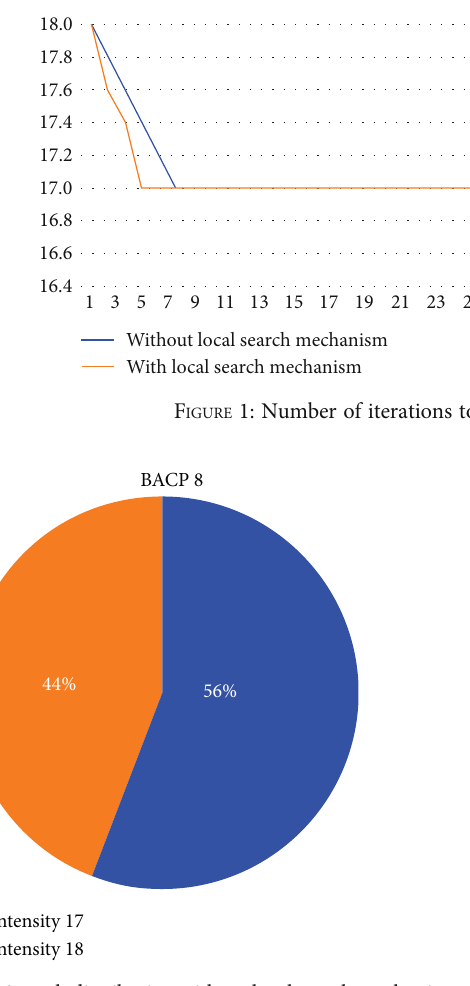
F IGURE 3: BACP 8 result distribution with local search